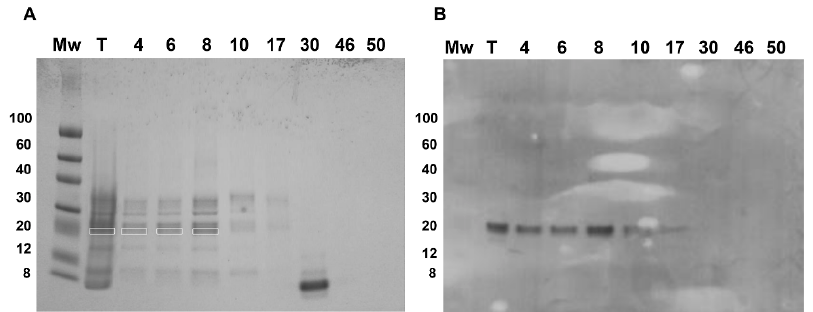
Figure 6. Sodium dodecyl sulphate polyacrylamide gel electrophoresis (SDS-PAGE) in reducing conditions of di ff erent fractions obtained in size exclusion chromatography ( A ) and immunoblot with PVF4 phage-dAb ( B ) of 10 µ g of pistachio extract (T) and 10 µ L of each fraction sample. Mw of the protein marker bands (ColorBurst TM Electrophoresis Protein Marker, Merck KGaA, Darmstadt, Germany) is indicated. Highlighted bands were excised and analysed by matrix-assisted laser desorption / ionization tandem mass spectrometry (MALDI-TOF/TOF). Phage-dAb in the immunoblot was detected with anti-M13 monoclonal mouse antibody conjugated with Horseradish peroxidase (HRP).